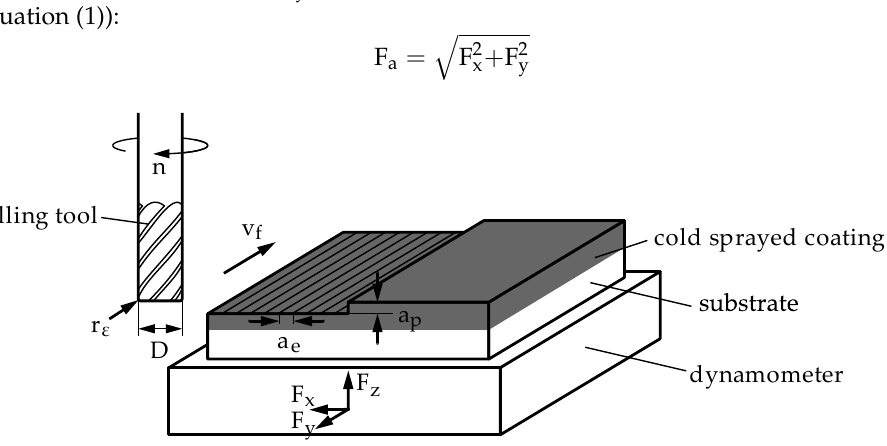
Figure 1. Experimental setup for the milling experiments.